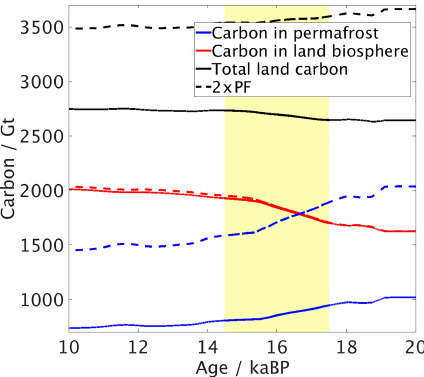
Figure 6. Carbon stored in soil below permafrost and in the terres- trial biosphere as well as their sum for the REF and for the 2xPF